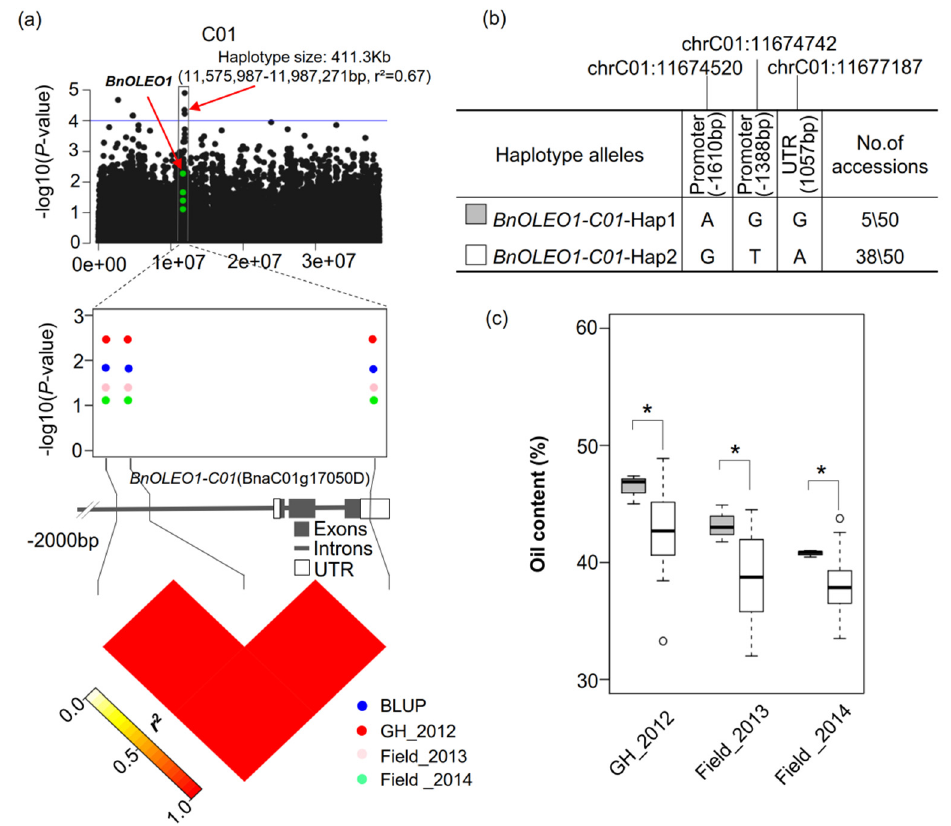
Figure 4. Regional association analysis of seed oil content on chromosome C01 by whole-genome resequencing of 50 accessions. ( a ) Haplotype region (11,575,987–11,987,271 bp, r 2 = 0.67) was significantly associated with seed oil content. The chrC01:11,674,520, chrC01:11,674,742, and chrC01:11,677,187 SNPs are located in the promoter and UTR of BnOLEO1-C01 (BnaC01g17050D) in the haplotype region, respectively. The heatmap shows that these SNPs have a strong LD. ( b ) Two haplotype alleles with frequencies greater than 0.01 were identified in BnOLEO1-C01 . ( c ) Comparative analysis of two haplotype alleles related to the oil contents of inbred lines. The boxplots show that BnOLEO1-C01 -Hap1 has a higher oil content than BnOLEO1-C01 -Hap2. *: p ≤ 0.05.